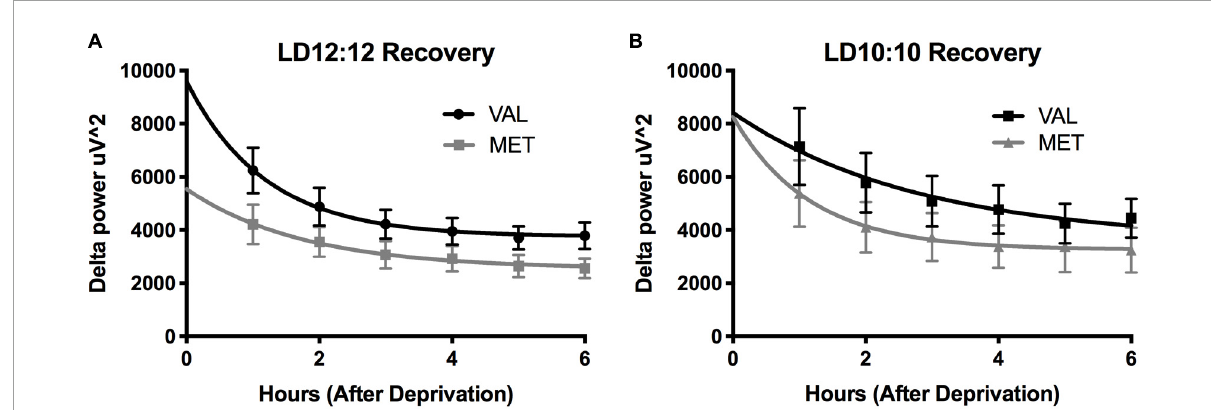
FIGURE4 Environmental circadian desynchronization does not significantly impact the EEG response to sleep deprivation in either genotype. Graphs depict changes in EEG responses following sleep deprivation. Sleep deprivation significantly increased delta power during NREM recovery sleep. Val (black) and Met (gray) mice in baseline LD12:12 (A) show an increase in NREM delta power following 6 h of sleep deprivation that decays over time. After 20 days of LD10:10 ECD (B) , the same relationship can be observed in both groups during recovery sleep following 6 h of sleep deprivation.